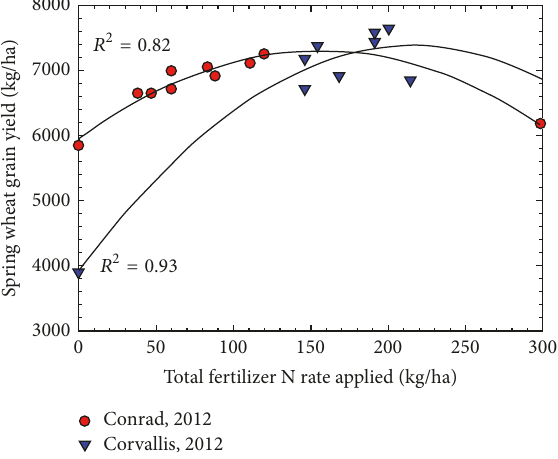
Figure 3: Spring wheat grain yield as affected by total amount of applied N fertilizer, Conrad and Corvallis, MT, 2012.